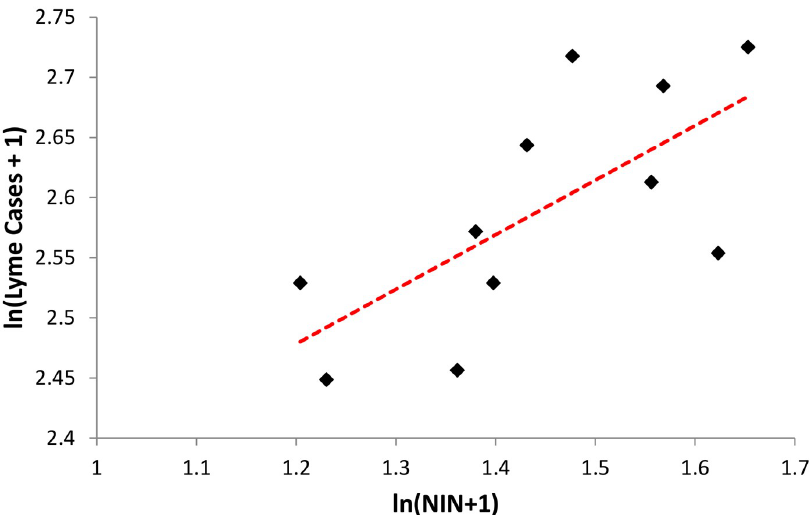
Fig 5. Relationship between number of infected I . scapularis nymphs (NIN) and Monmouth County Lyme disease cases, 2006–2016.